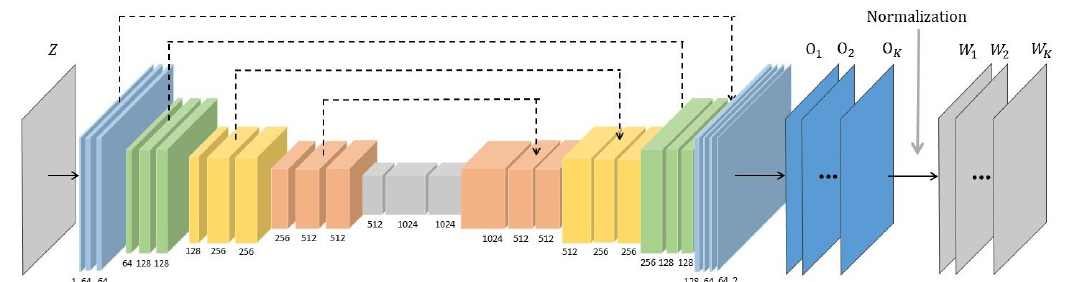
Figure 4. Structure of our backbone network. Z refers to the initial random noise. O 1 , O 2 ,..., O K are the generated original weight maps. W 1 , W 2 ,..., W K are the weight maps after